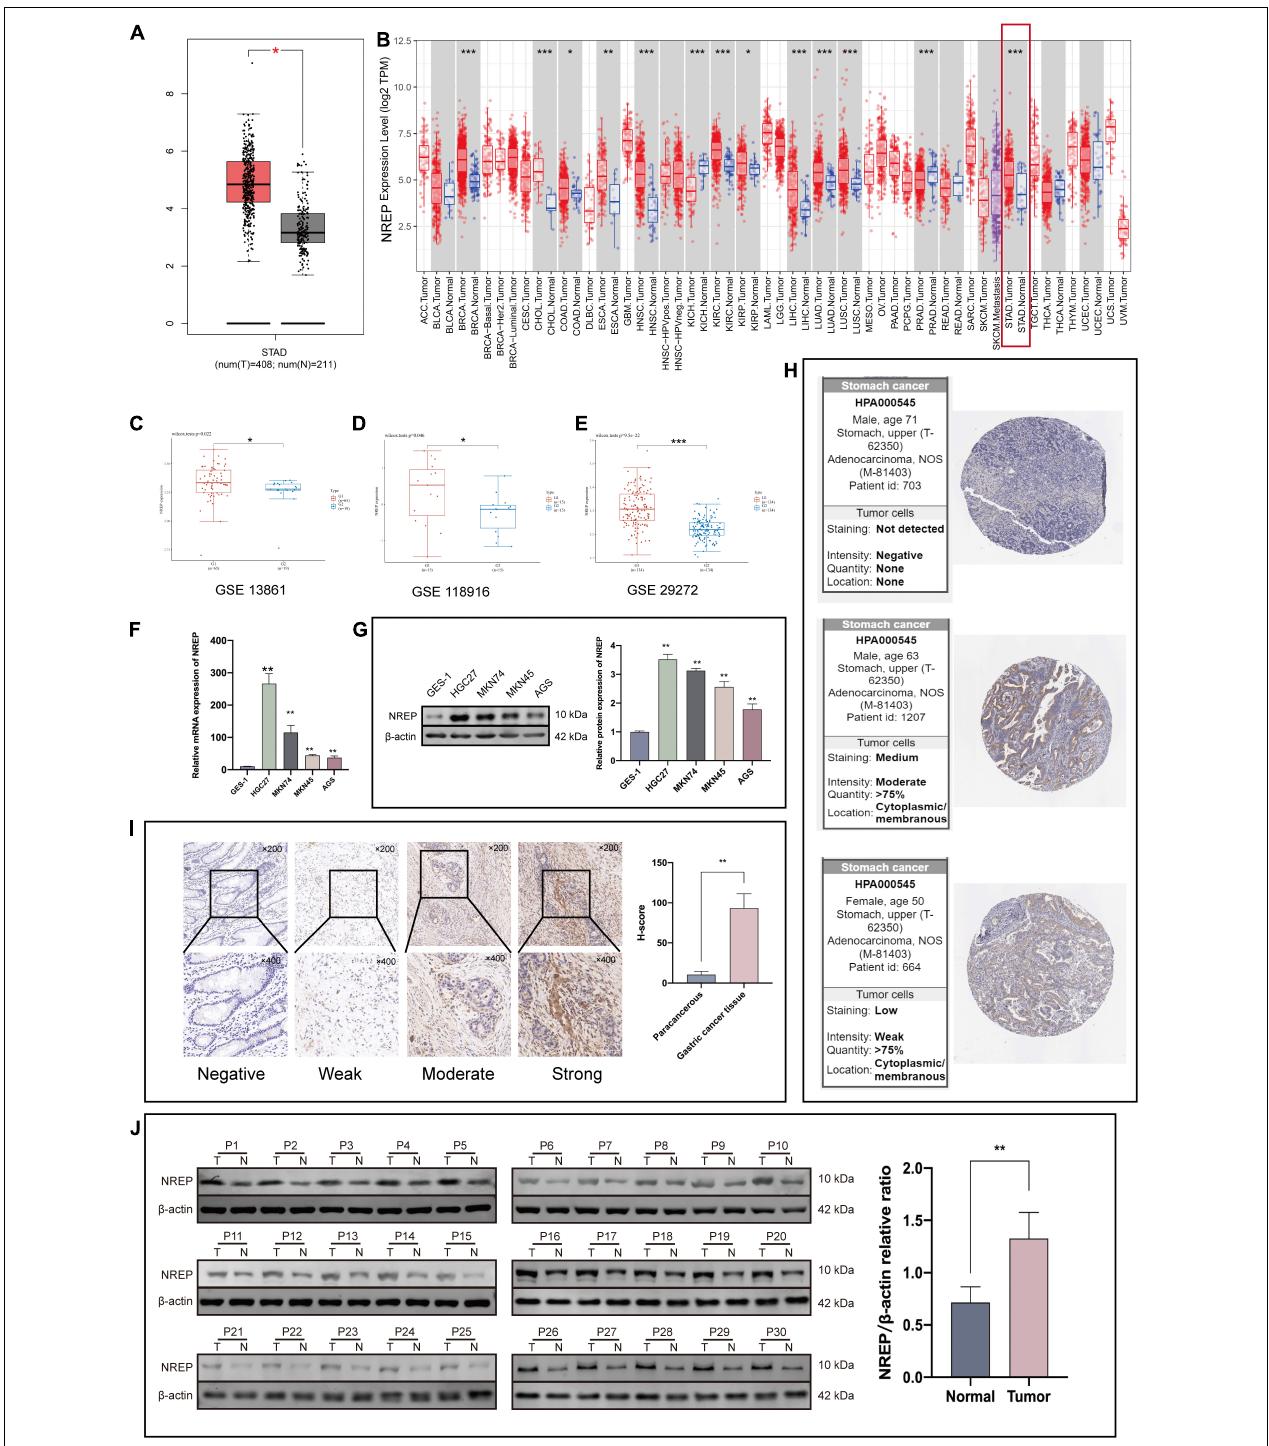
FIGURE 1 | NREP levels in gastric cancer (GC) tissue. (A) Expression levels of NREP in GC based on The Cancer Genome Atlas (TCGA)-STAD data. (B) NREP mRNA levels in GC and normal tissue based on the TIMER database. (C–E) Public datasets from Gene Expression Omnibus (Fei et al., 2018; Li et al, 2020; Shan et al., 2021) used to verify NREP mRNA levels in GC. (F,G) NREP mRNA (F) and protein expression (G) in normal gastric epithelial cells and GC cells. (H) NREP immunohistochemistry in GC tissue based on data from the Human Protein Atlas. (I) Intensity of NREP immunohistochemistry staining and NREP expression levels in paracancerous and GC tissue ( n = 30). (J) NREP expression in GC tissues (T) and paired non-tumorous tissue (N) evaluated using western blotting ( n = 30). (NS: not significant, * P < 0.05, ** P < 0.01, and *** P < 0.001).